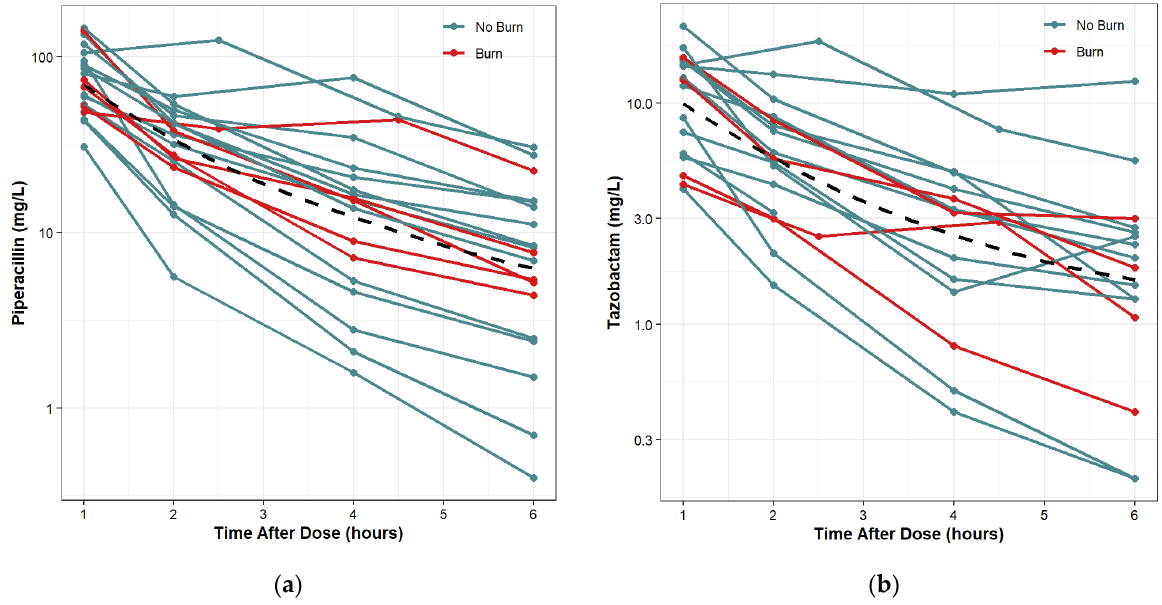
Figure 3. Time ‐ concentration plots with LOESS trend lines: ( a ) piperacillin; ( b ) tazobactam